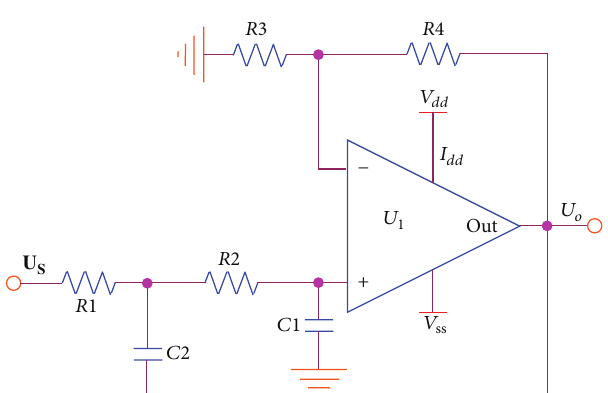
Figure 2: Second-order Sallen-key filter, where 𝑅1 , 𝑅2 , 𝑅3 and 𝑅4 are 10k Ω , 𝐶1 and 𝐶2 are 4.7